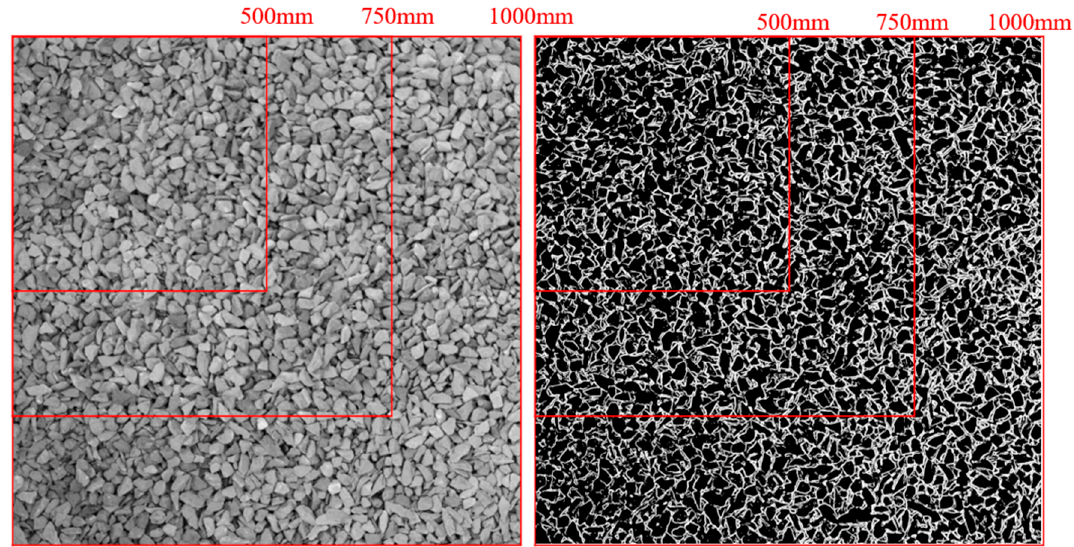
Figure 6. Images of 6–9 mm coal particles.